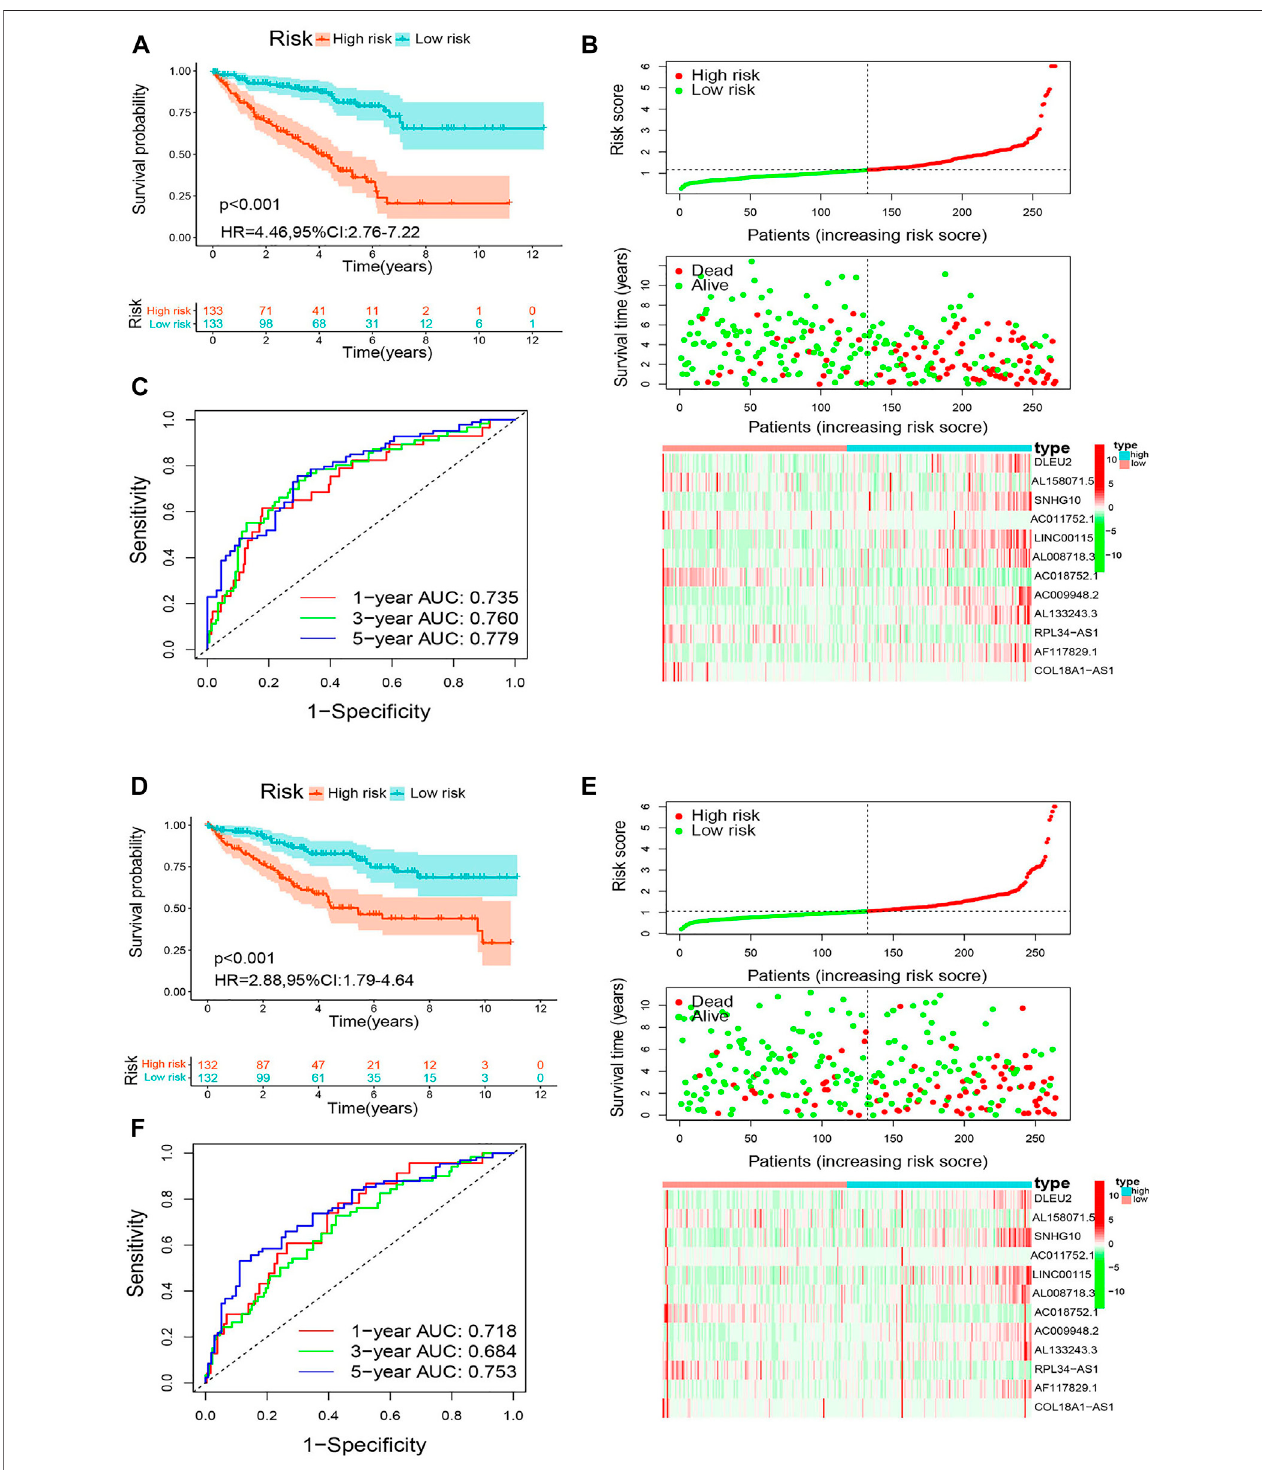
FIGURE7| Analysisofthem6A-RLPSef fi cacyinpatientsstrati fi edbyrisklevel. (A) Kaplan – Meiercurvesofoverallsurvival(OS)forthem6A-RLPS (B) Distributions of risk scores, survival status, and relative lncRNA expression; and (C) ROC curves for predicting 1-, 3-, and 5-years OS rates in the training cohort. (D) Kaplan – Meier curvesofOSfor them6A-RLPS(E) Distributions ofriskscores, survivalstatus,and relativelncRNA expression; and (F) ROCcurvesforpredicting 1-, 3-,and 5-years OS rates in the fi rst validation cohort.